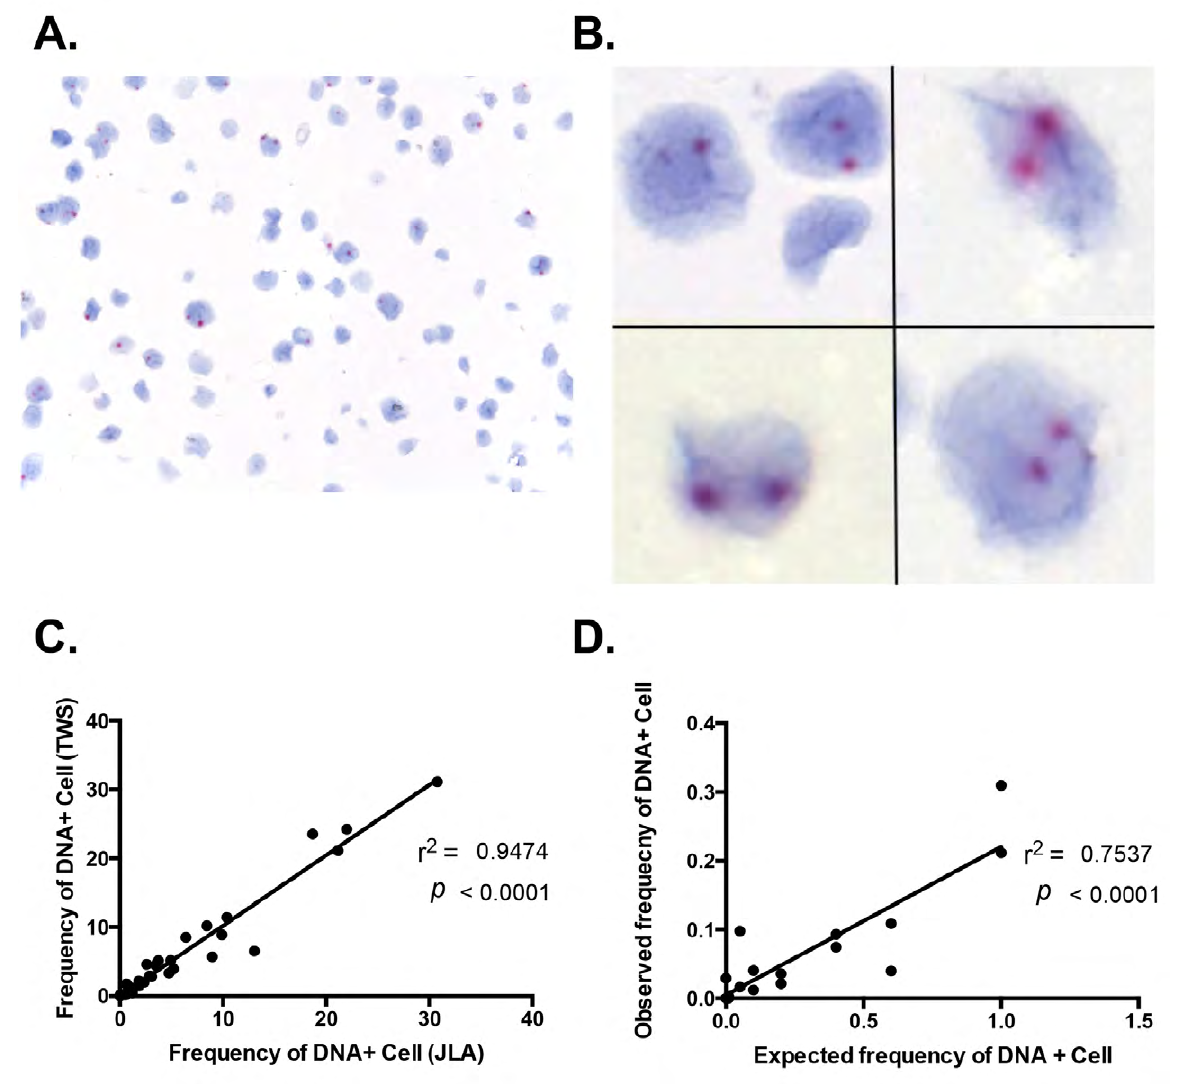
Supplemental Figure 5. Detection and quantification of HIV-1 vDNA in ACH-2 cells. Low (A) and high (B) magnification images showing HIV-1 vDNA (Red) by DNAscope in ACH-2 cells. Note that the nuclei of many ACH-2 cells contain multiple copies of vDNA, consistent with multiple integration sites per ACH-2 cell. (C) Quantification is highly reproducible between independent blinded users. (D) Strong correlation between the actual and expected frequencies of vDNA+